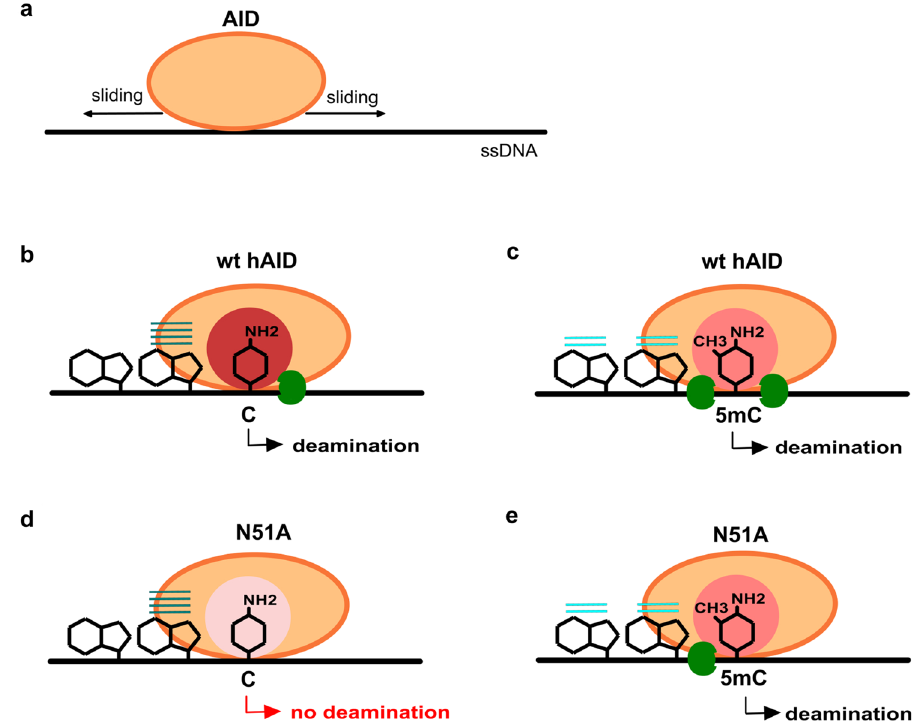
Figure 7. Proposed mechanism of hAID-catalyzed deamination. ( a ) hAID binds to ssDNA and slides bidirectionally along this molecule. ( b – e ) Occasionally, the enzyme pauses to deaminate C or 5 mC. There are three elements that determine the enzyme’s propensity to pause: (1) the network of interactions between the catalytic pocket and the pyrimidine ring that position the latter (red circles; the shade of the color corresponds to the strength of the interactions, with darker colors corresponding to stronger interactions); (2) the network of interactions between hAID and the ssDNA sugar-phosphate backbone (one or two green circles); (3) the stacking interactions between the aromatic residues of the protein and nucleobase(s) adjacent to C/5 mC (blue lines; the shade of the color and the number of lines correspond to the stability of the interactions, with darker colors and more lines indicating increased stability. ( b ) The ability of wt hAID to pause and deaminate C is determined by (1) strong stabilization of the pyrimidine ring in the catalytic pocket; (2) N51 residue interactions with the sugar-phosphate ssDNA backbone; and (3) stable stacking interactions (W84:Y114:G). ( c ) The ability of wt hAID to pause and deaminate 5 mC is determined by (1) sufficient stabilization of the pyrimidine ring in the catalytic pocket; (2) double anchoring of the sugar-phosphate ssDNA backbone (by interactions specific to the N51 residue and to the methyl group); and (3) unstable stacking (W84:Y114:G) or alternative stacking (A:Y114:G). ( d ) The N51A mutant failed to deaminate C due to (1) insufficient stabilization of the pyrimidine ring and (2) the lack of an ssDNA backbone anchoring. The stacking (W84:Y114:G) is stable in this case. ( e ) The N51A mutant retains its activity on 5 mC because of (1) sufficient stabilization of the pyrimidine ring and (2) anchoring of the sugar-phosphate ssDNA backbone mediated by the methyl group. In this case, the stacking (W84:Y114:G) is unstable, or alternative stacking (A:Y114:G) is